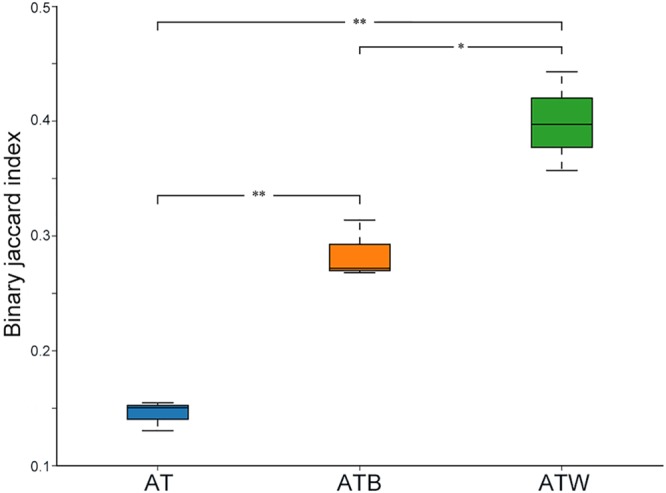
Inter-group beta diversity box diagram. The x-axis represents the grouping, the y-axis represents the distance, and the boxes of different colors represent each group. ∗p < 0.05; ∗∗p < 0.01.